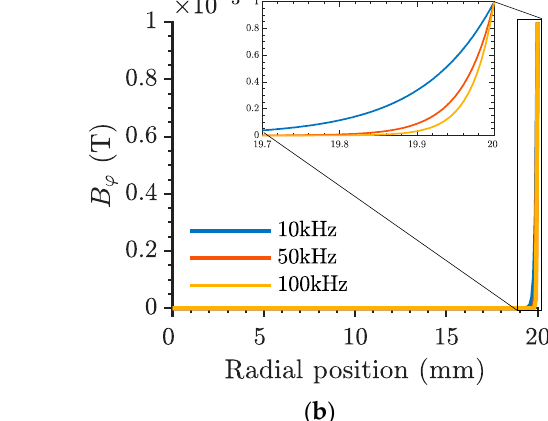
Figure 2. Distribution of eddy current and magnetic flux density along radius in the analytical model: ( a ) variation of current density with radius; ( b ) variation of magnetic flux density with radius.